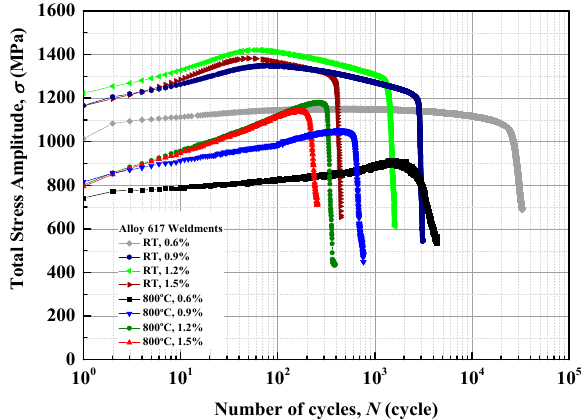
Figure 3. The cyclic stress response curves regarding to four total strain ranges under continuous cyclic loading for Alloy 617 weldments.